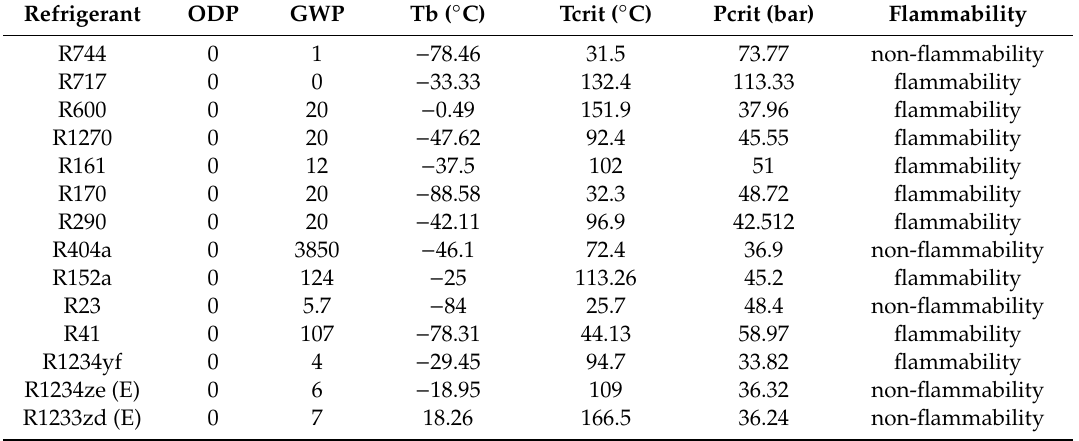
Table 2. Standard parameters of various refrigerants reviewed in CRS.